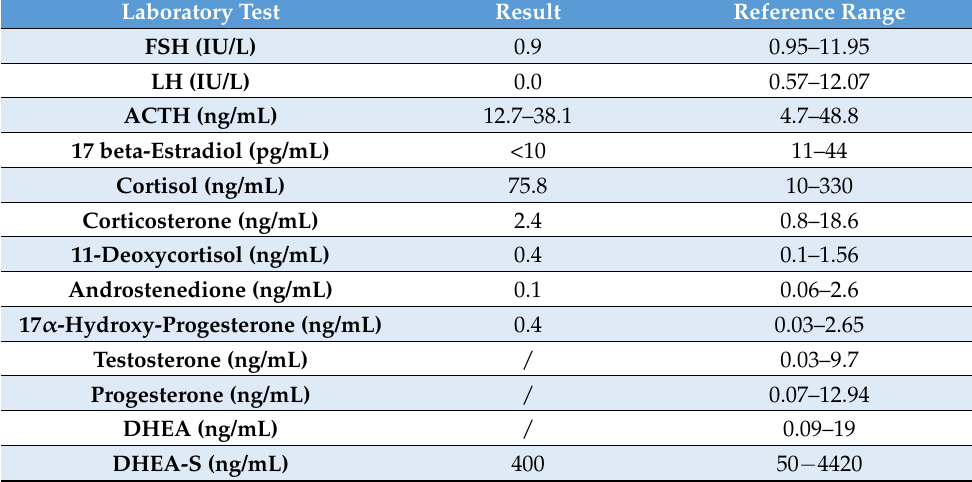
Table 2. Serum steroids and pituitary hormones at the time of presentation using different reporting units (compared with the recommended pediatric reference